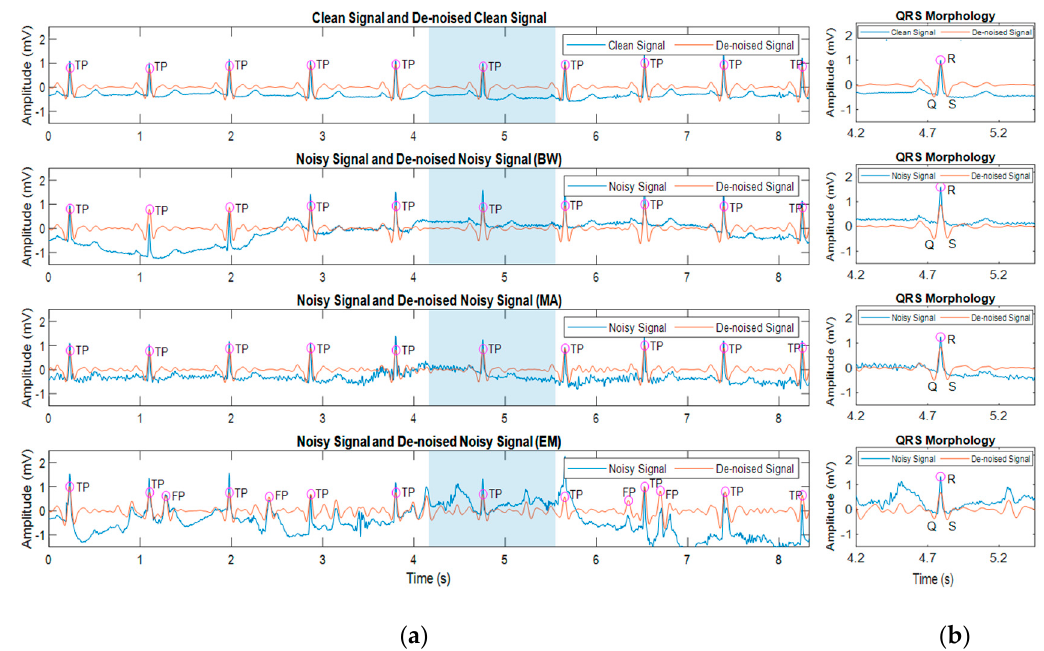
Figure 5. Visual evaluation of the ECG morphologies as affected by clean and noisy signals with a SNR of 0 dB ( a ) ECG Signal and De-Noised ECG Signal; ( b ) the QRS morphologies of heartbeat.